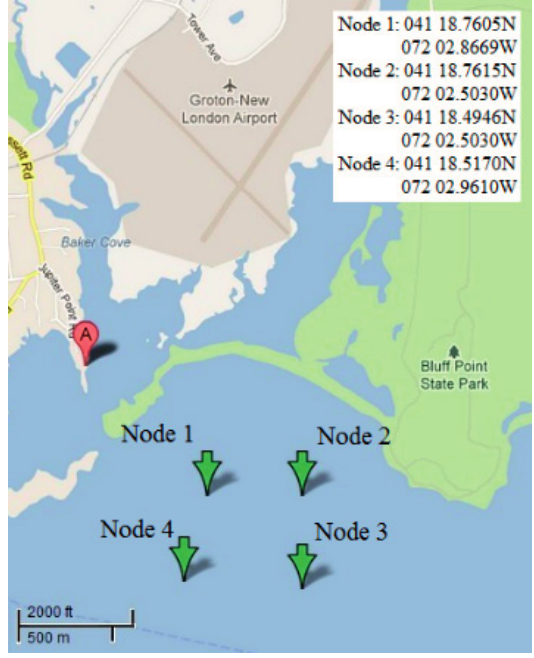
Figure 6. Area of collected channel data.